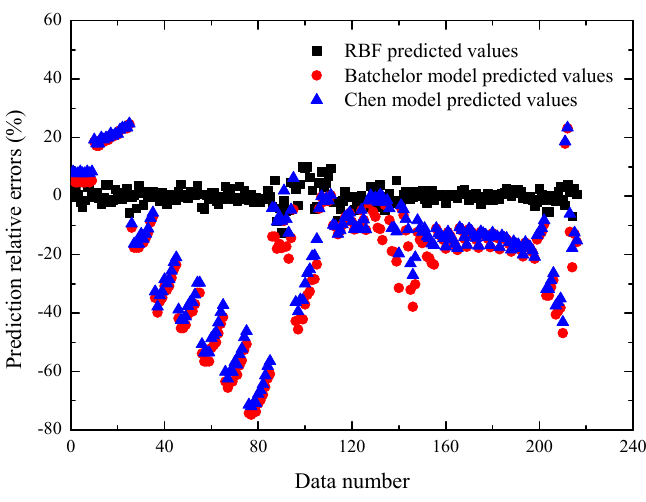
Figure 6. Prediction relative errors of different models for the total viscosity data. Table 4. Performance evaluation of different modes for the total viscosity data.